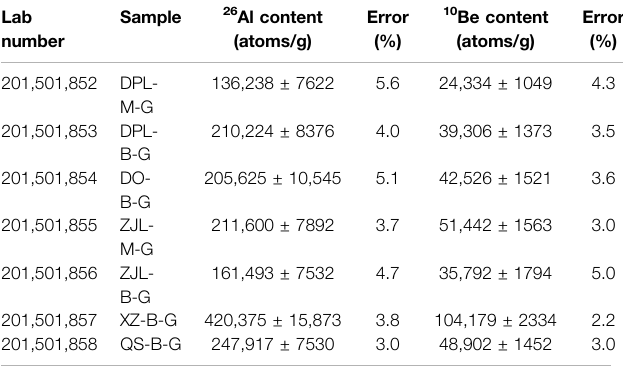
TABLE 2 | Contents of 26 Al and 10 Be in quartz